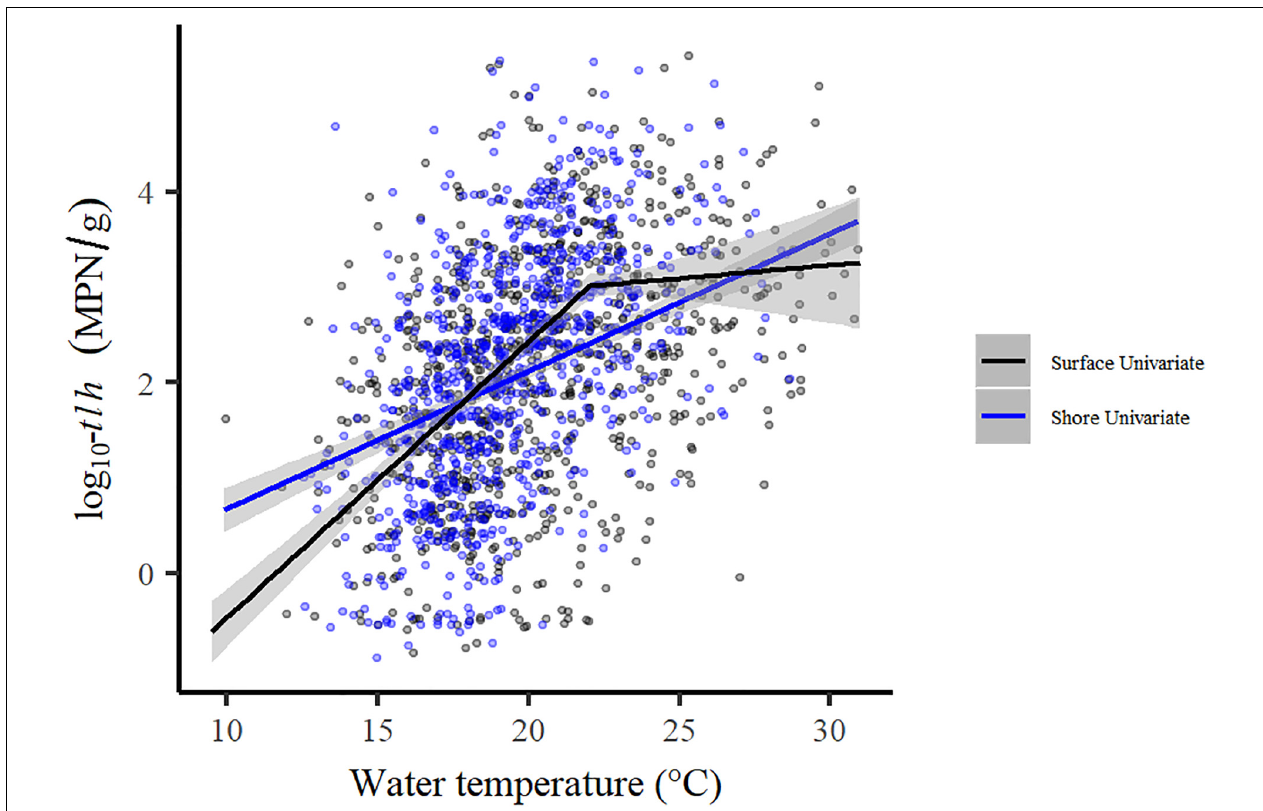
FIGURE 4 | Comparison of univariate regressions for shore versus surface water temperature and total V. parahaemolyticus .